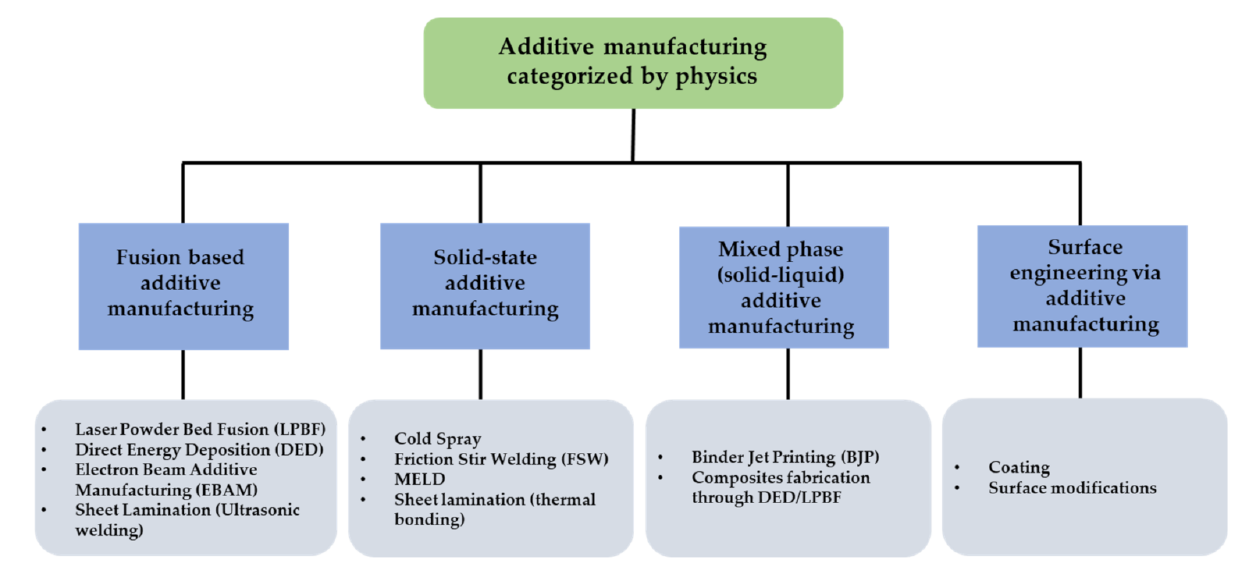
Figure 1. Additive manufacturing techniques are categorized by the physics involved during their fabrication.